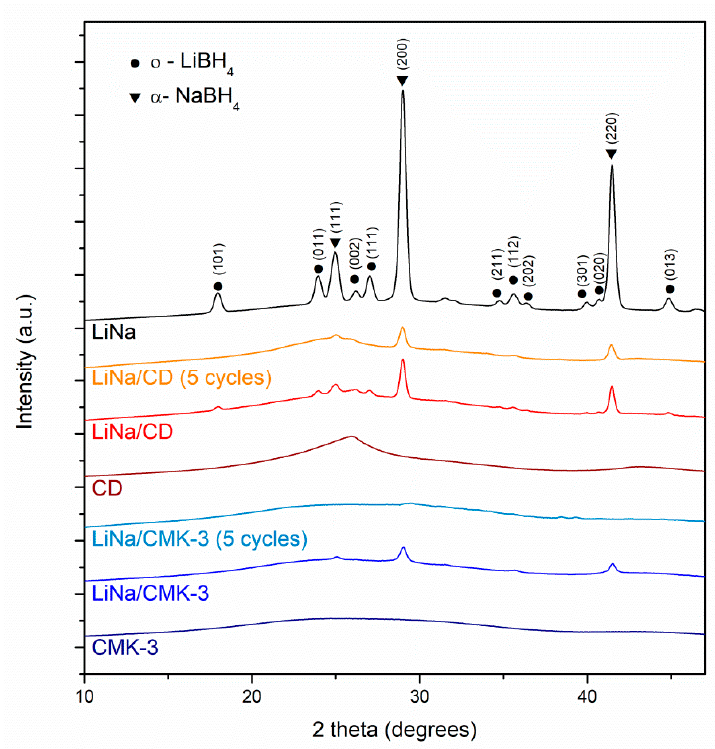
Figure 1. XRPD patterns of pure carbons (CMK-3 and CD), bulk 0.71 LiBH 4 –0.29 NaBH 4 eutectic mixture (LiNa), the carbon/borohydride composites (LiNa/CMK-3 and LiNa/CD) as well as the composites after 5 dehydrogenation and rehydrogenation cycles. The peak labels indicate the following phases: orthorhombic o-LiBH 4 (•), α -NaBH 4 ( ▾ ).